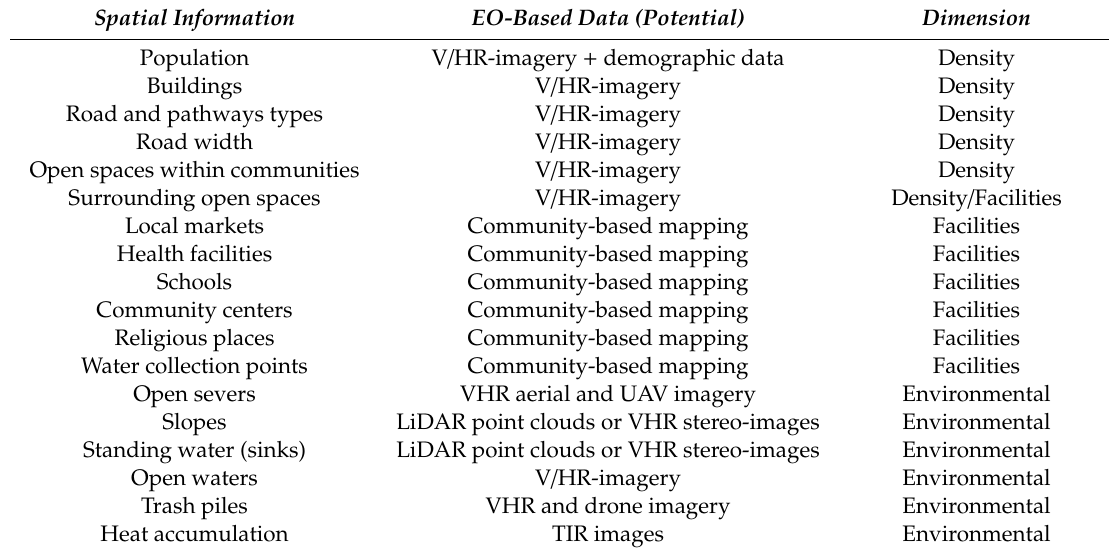
Table 1. Relevant spatial information in responding to the COVID-19 outbreak in slums and the potential of Earth observation (EO) based data.